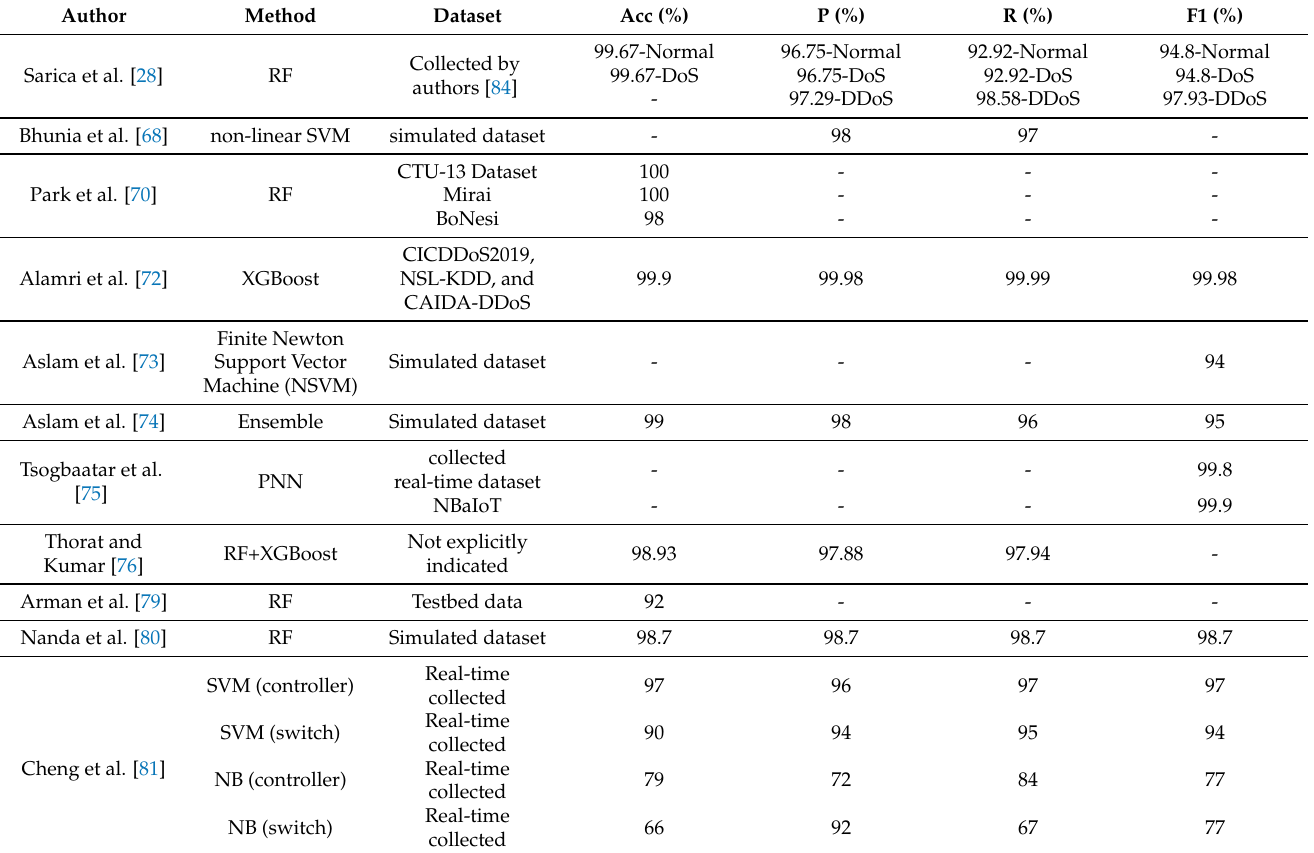
Table 4. Summary of BotNet attack Detection using Classical Machine Learning in an SDN-enabled IoT